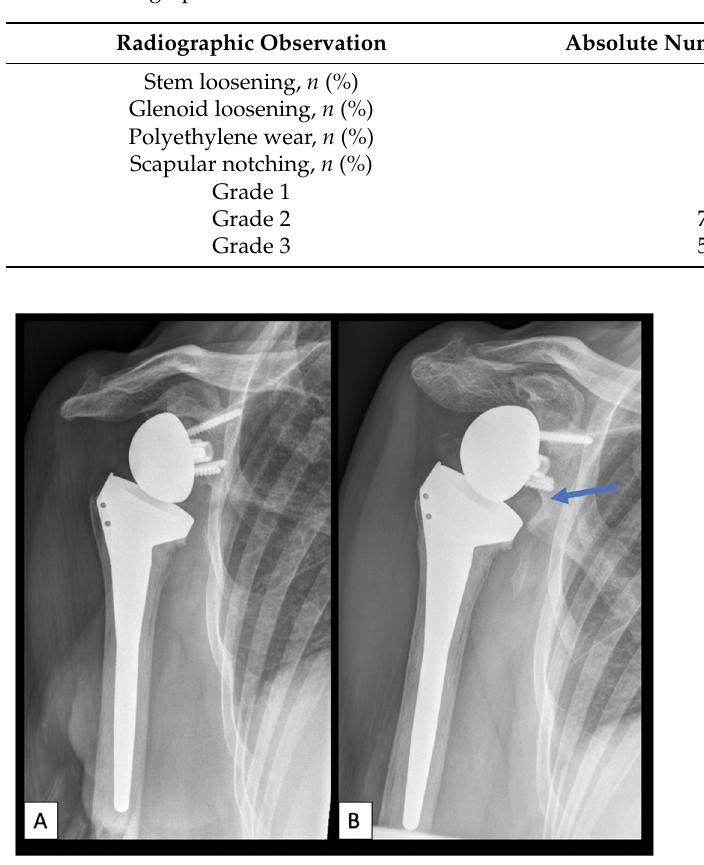
Figure 3. Scapular notching. ( A ): Anteroposterior radiograph of a right shoulder one-year postoperatively. ( B ): Anteroposterior radiograph of a right shoulder eight years postoperatively with scapular notching grade three according to the classification of Sirveaux [10]. Blue arrow demonstrating the area of scapular notching at the inferior glenoid.